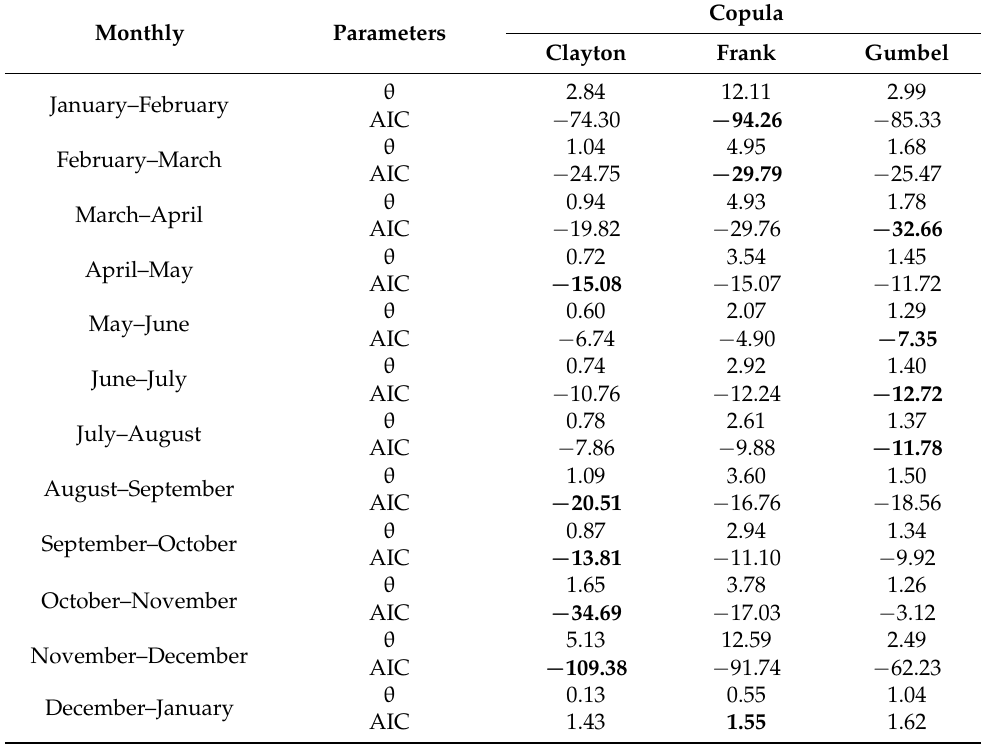
Table 2. Parameters and AIC of joint distribution of inflow in the NZD